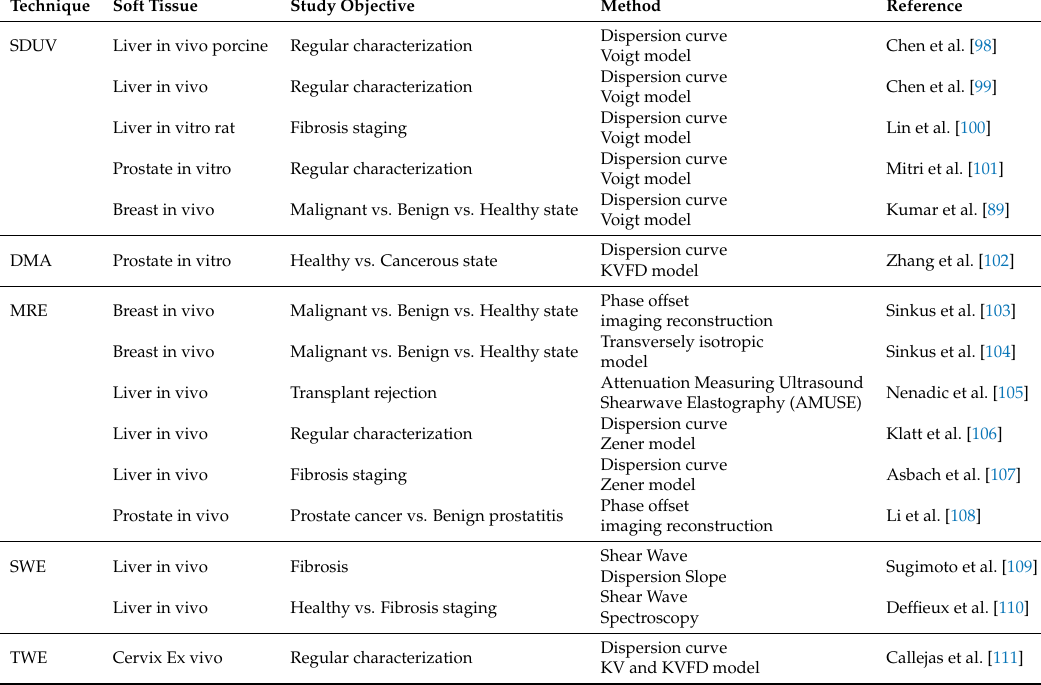
Table 1. Qualitative overview of the work done on the description of the viscoelastic nature of selected soft tissues. The techniques that have achieved remarkable results are: shear wave dispersion ultrasound vibrometry (SDUV), dynamic mechanical analysis (DMA), magnetic resonance elastography (MRE), shear wave elastography (SWE) and torsional wave elastography (TWE). KVFD: Kelvin–Voigt fractional derivate; KV: